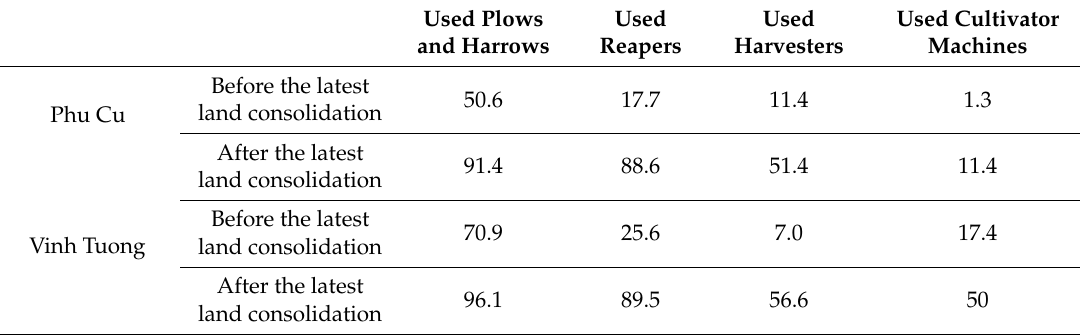
Table 9. Changes in the proportion of households applying machinery in rice cultivation during land consolidation.